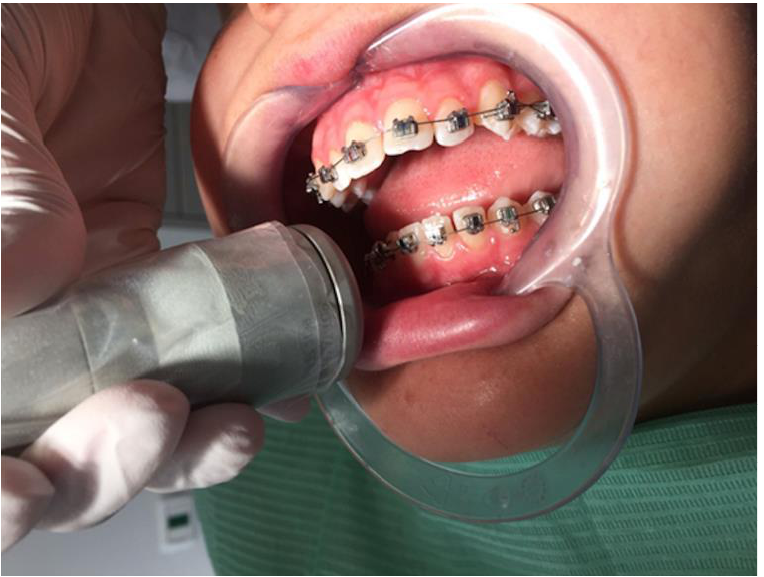
Figure 2. Flat Top handpiece for PBM in orthodontic treatment.